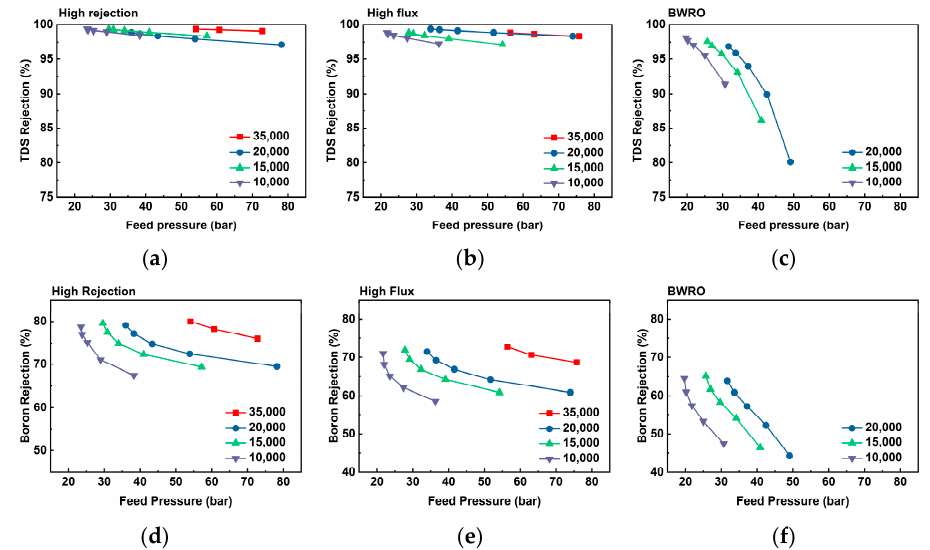
Figure 4. Boron rejection and TDS rejection by feed pressure by using high rejection membrane ( a , d ), high flux membrane ( b , e ), and braish water reverse osmosis (BWRO) membrane ( c , f ).